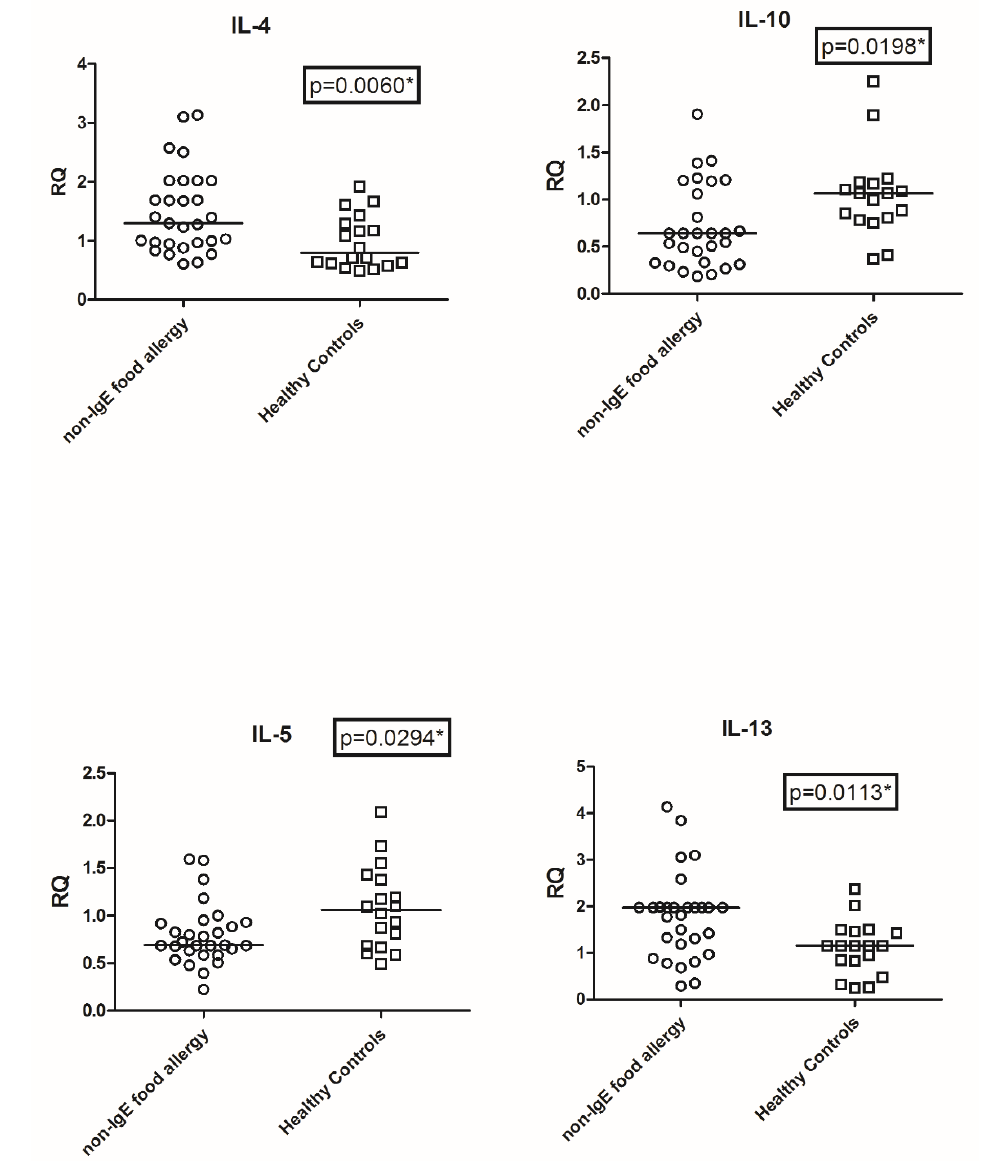
Figure 1. Transcription levels of IL4, IL5, IL10, and IL13 in Non-IgE-mediated food allergy and healthy controls. Footnote: Data are represented as box plots or circles. Relative ILs levels were assessed by real-time PCR and represented by fold change of Arbitrary Unity. RQ: Relative Quantitative units of fold change. Statistical significance was calculated by the Mann-Whitney t -test. Statistical significance has been set at p values of < 0.05, indicated with *.